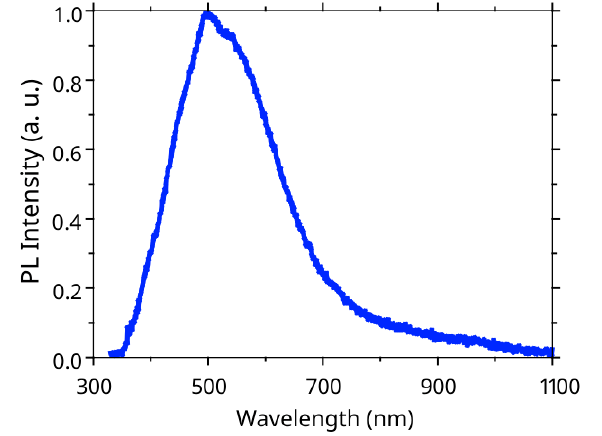
Figure 3. Normalized to the maximum PL response of the GaN/InGaN/GaN NWs synthesized on the Si/SiO 2 substrate.